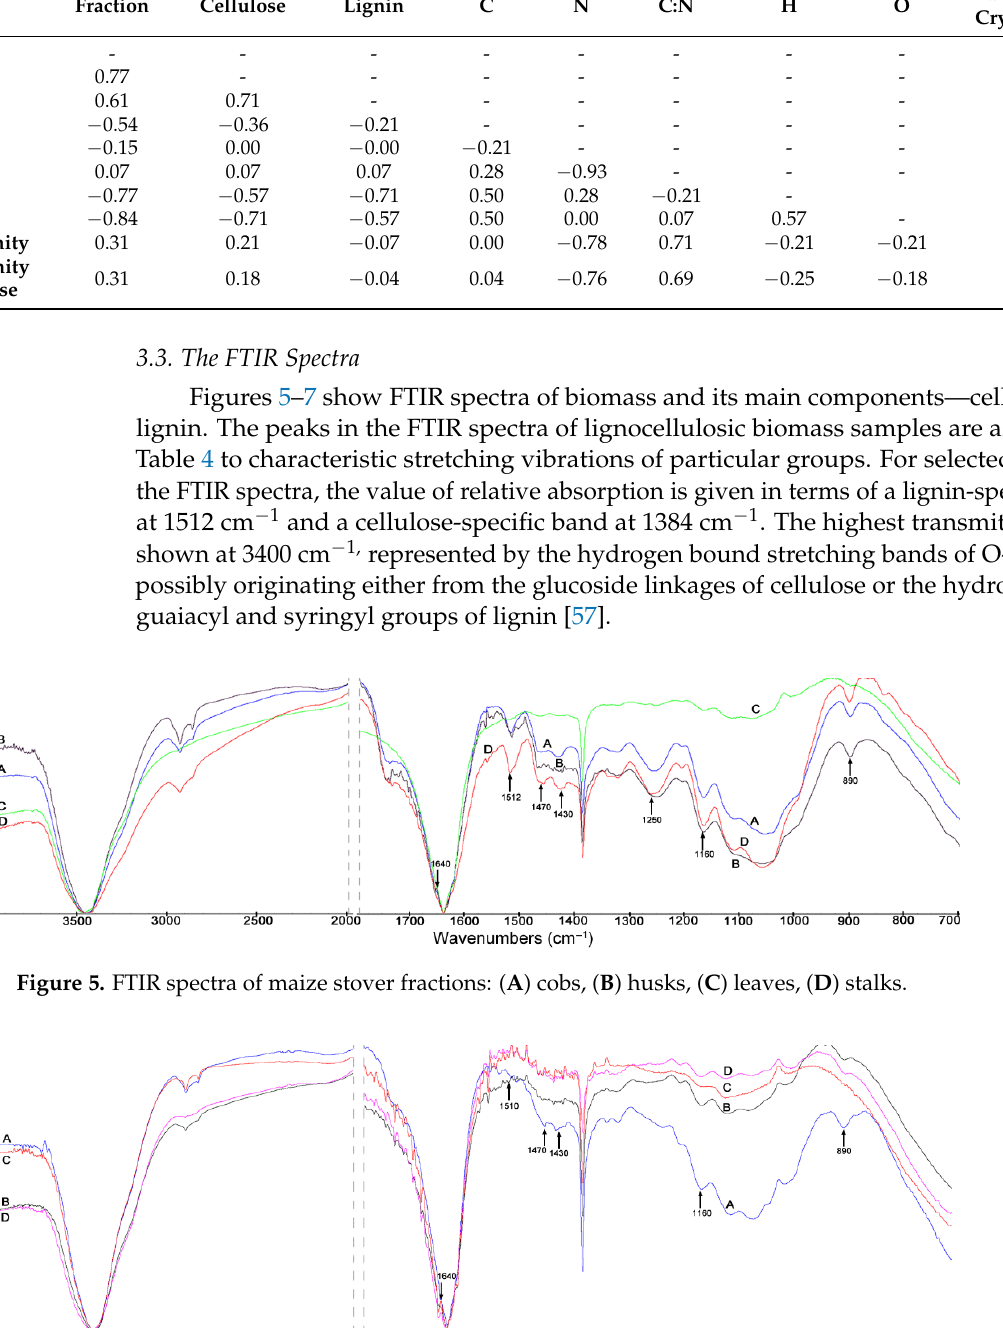
and 1470 cm −1 range. In the FTIR spectra of cobs, husks and stalks (Figure 5A,B,D), there are bands at 1160 cm −1 , characteristic for the C-O-C vibration in cellulose and hemicellu- lose.